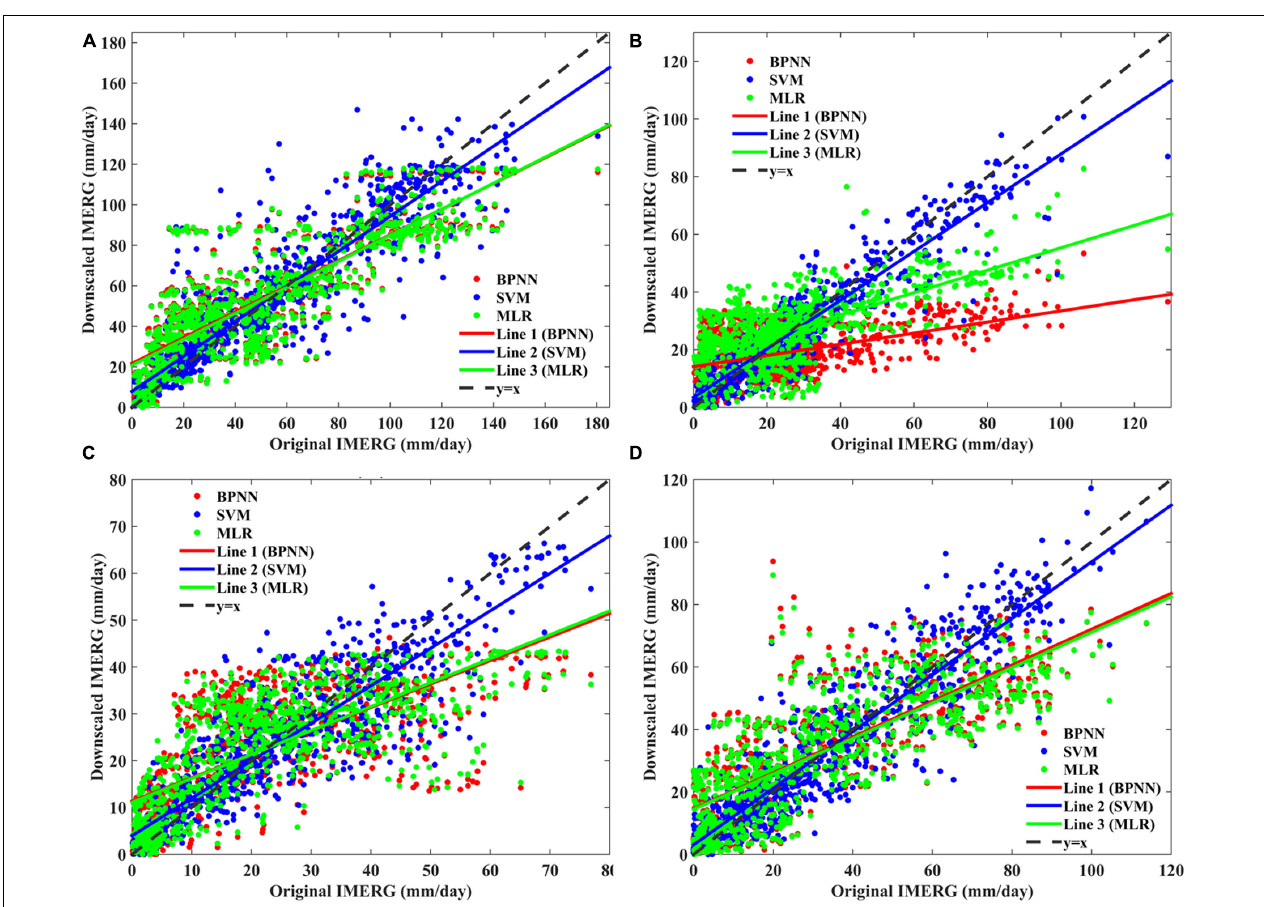
FIGURE 10 | The scatterplots of downscaled results by BPNN, SVM, and MLR against the original IMERG data in four precipitation events [ (A) for event 1, (B) for event 2, (C) for event 3, and (D) for event